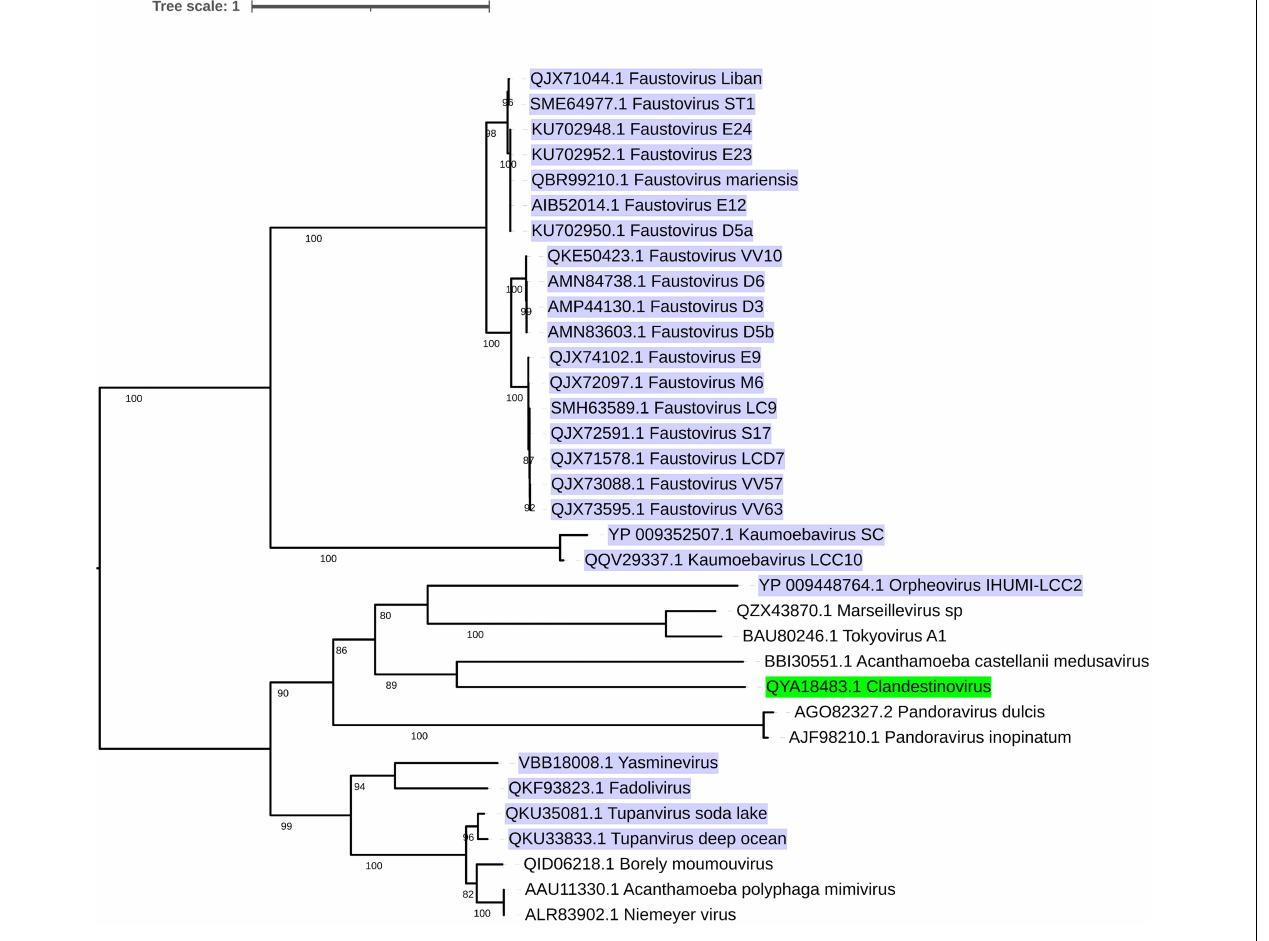
Frontiers in Microbiology |